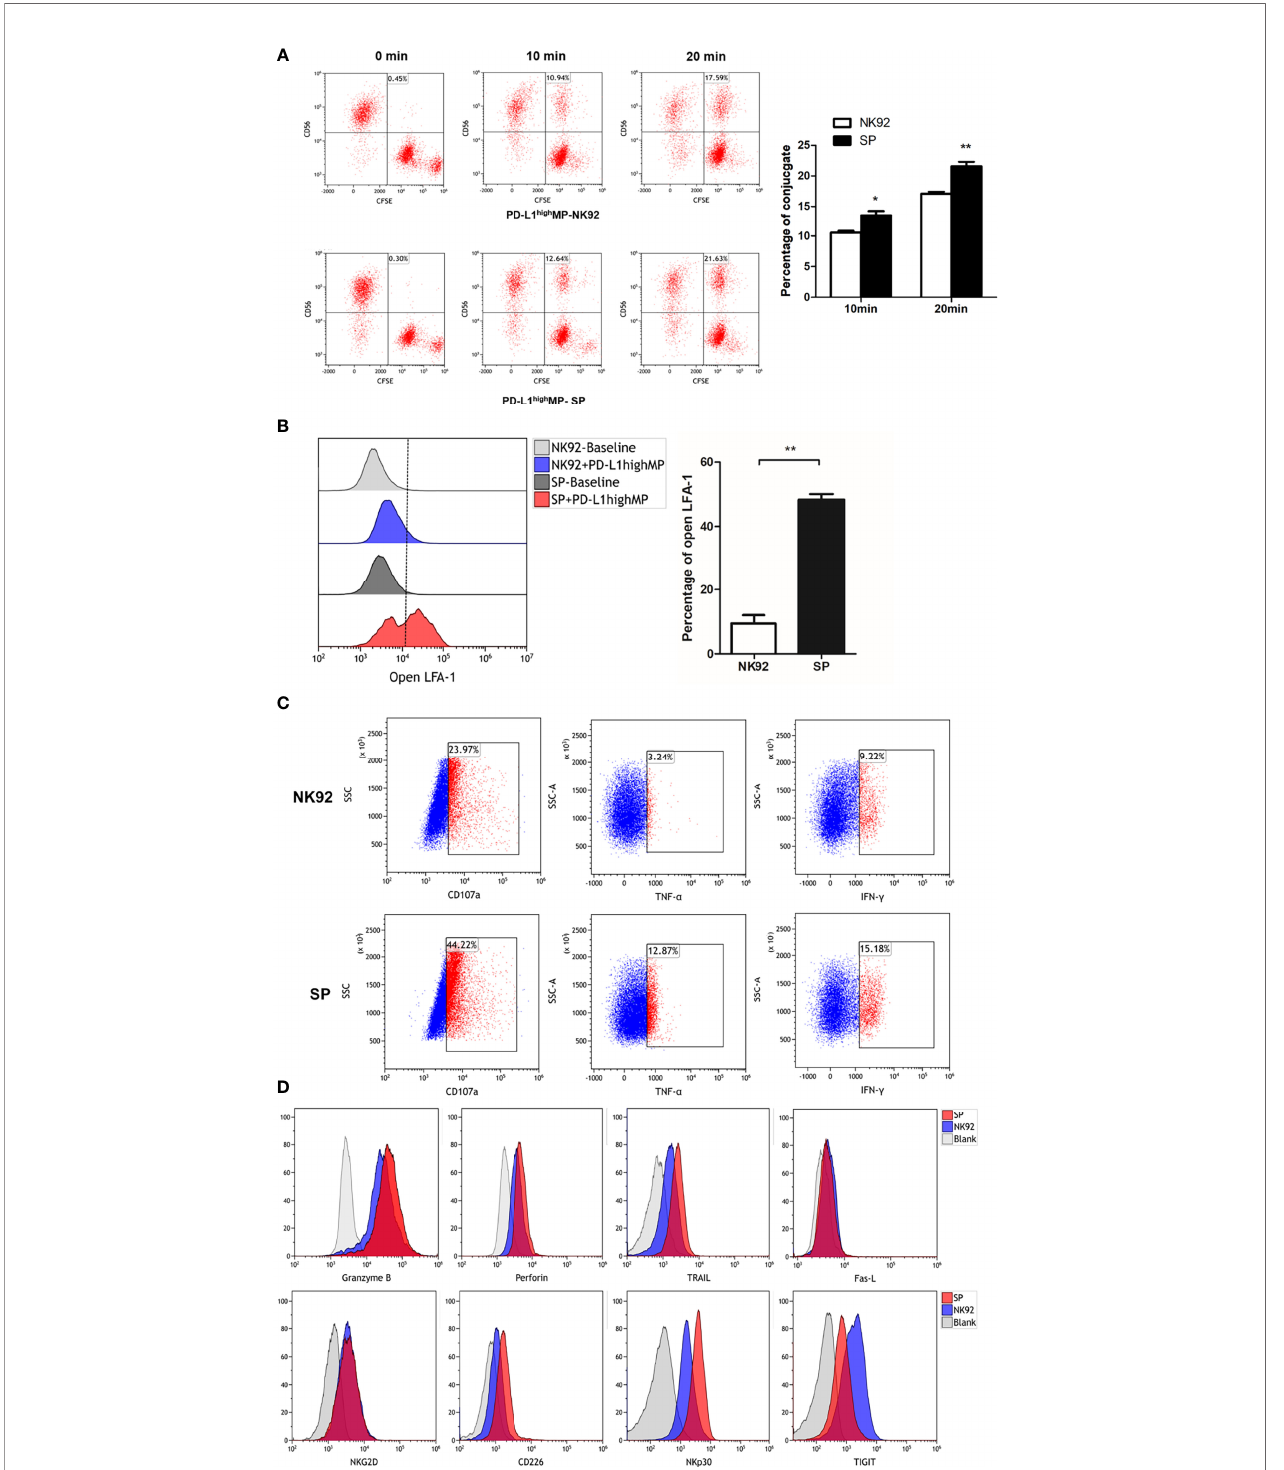
FIGURE 5 | FCM detection of SP cells conjugate formation, degranulation and cell death signaling transduction. (A) SP or NK92 cells were incubated with CFSE- labeled PD-L1 high MP cells and assessed for the proportion of conjugate formation (CFSE and CD56 double positive counts). (B) SP or NK92 cells were assessed for the expression of LFA-1 in open-conformation following incubation with PD-L1 high MP. (C) CD107a, TNF- a and IFN- g expression of SP or NK92 cells were detected after a 6-hour incubation with PD-L1 high MP. (D) SP or NK92 cells were assessed for expression of markers including granzyme B, perforin, TRAIL, Fas-L, NKG2D, CD226, NKp30, and TIGIT using FCM. For panels A and B, dummary data are shown as mean ± SEM (*P < 0.05, **P < 0.01, n =